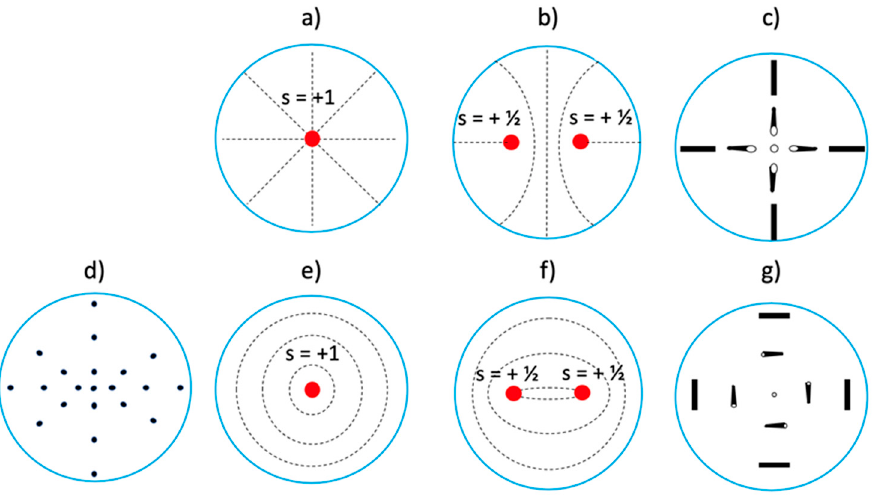
Figure 2. Schematic cross-sections of director fields for nematic phases of LCs in cylindrical confinement. ( a – c ) occur when there is perpendicular anchoring at the surface and ( d – g ) when it is planar.